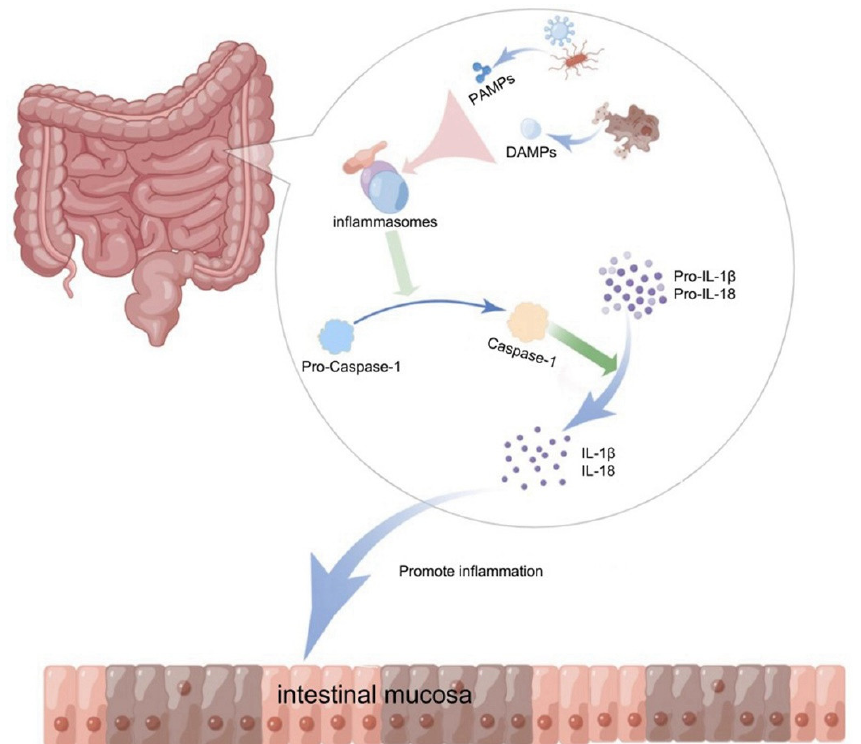
Figure 1. Activated inflammasomes in the gut recognize stimuli and initiate inflammatory responses. Inflammasomes in the intestine recognize the pathogen-associated molecular patterns (PAMPS) of exogenous pathogens invading the host, or the damaged and dying cells release the dangerous-associated molecular patterns (DAMPs) in the body, which will stimulate ASC to assem- ble with pro-caspase-1 to form inflammasomes. The assembled inflammasomes promote pro- caspase-1 to self-cleavage and produce activated caspase-1, and the activated caspase-1 will convert pro-IL-1 β and pro-IL-18 to IL-1 β and IL-18, which in turn triggers an inflammatory response in the intestine (diagram by Figdraw).